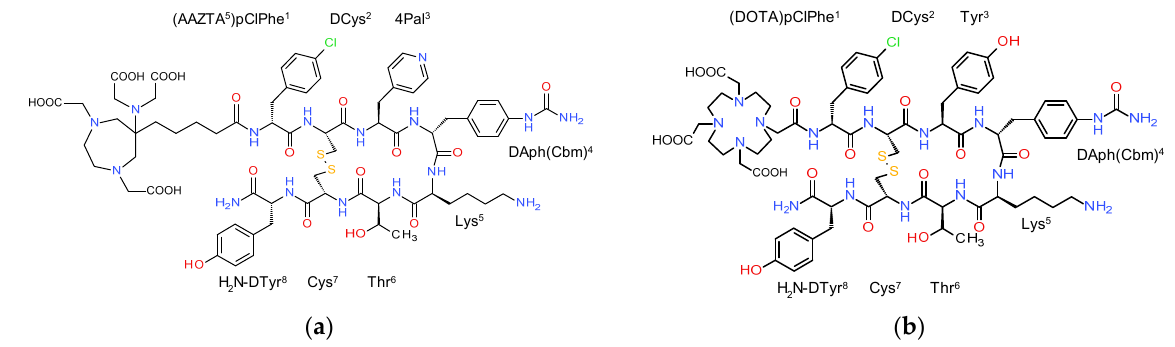
Figure 1. Chemical structures of ( a ) AAZTA 5 ‐ LM4; ( b ) DOTA ‐ LM3; the two analogs differ in the chelator (AAZTA 5 : 1,4 ‐ bis(carboxymethyl) ‐ 6 ‐ [bis (carboxymethyl)]amino ‐ 6 ‐ [pentanoic ‐ acid]perhy ‐ dro ‐ 1,4 ‐ diazepine and DOTA: 1,4,7,10 ‐ tetraazacyclododecane ‐ 1,4,7,10 ‐ tetraacetic acid) and in the residue at position 3: 4Pal (4 ‐ pyridyl)alanine) in LM4 and Tyr in LM3; DAph(Cbm): D ‐ 4 ‐ (car ‐ bamoyl)amino ‐ phenylalanine).